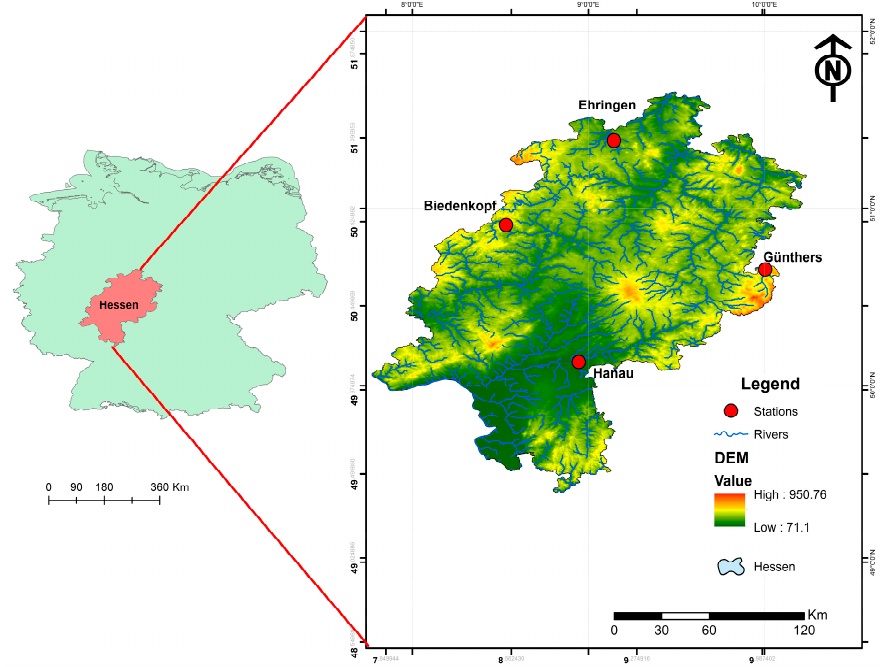
Figure 1. The location of the selected stations (Ehringen, Biedenkopf, Günthers, and Hanau) on the selected rivers (Erpe, Kinzig, Lahn, and Ulster) in Hesse. Note: Source of DEM [https://www.bkg.bu nd.de/EN/Home/home.html (accessed on 20 October